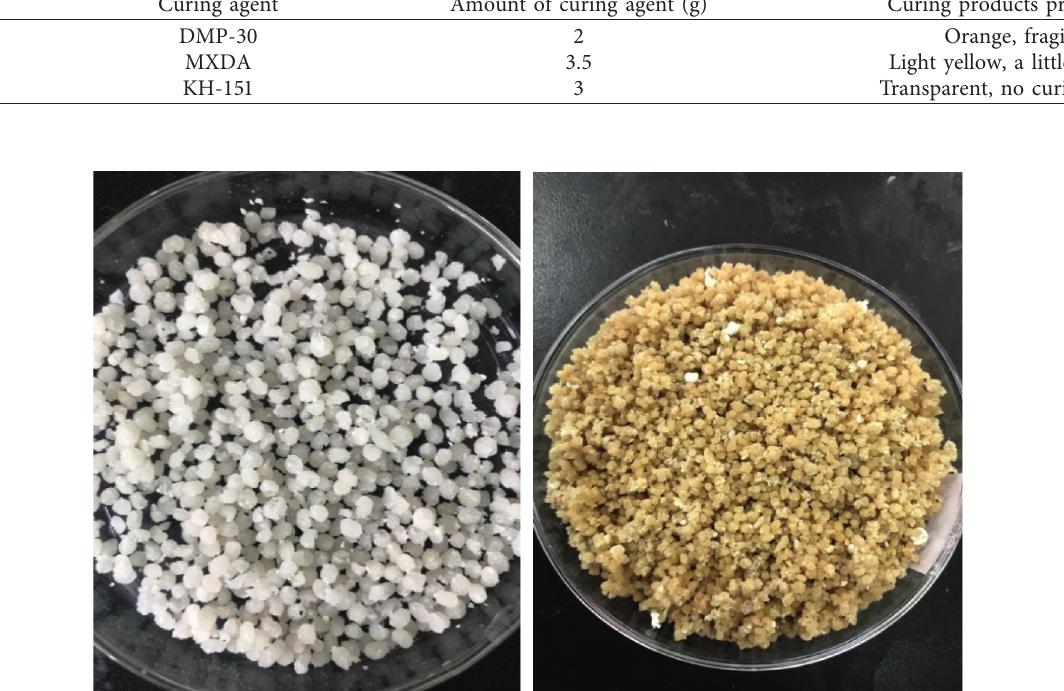
Figure 7: Particles of the core material: (a) particles before dried; (b) particles after dried.